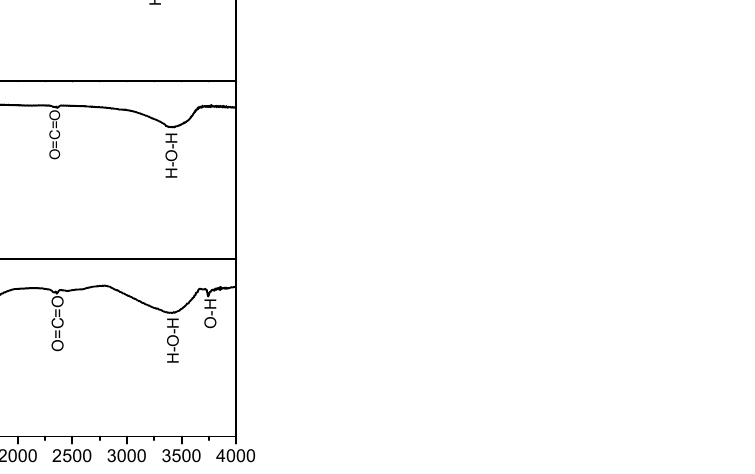
Nanomaterials 2021 , 11, x FOR PEER REVIEW